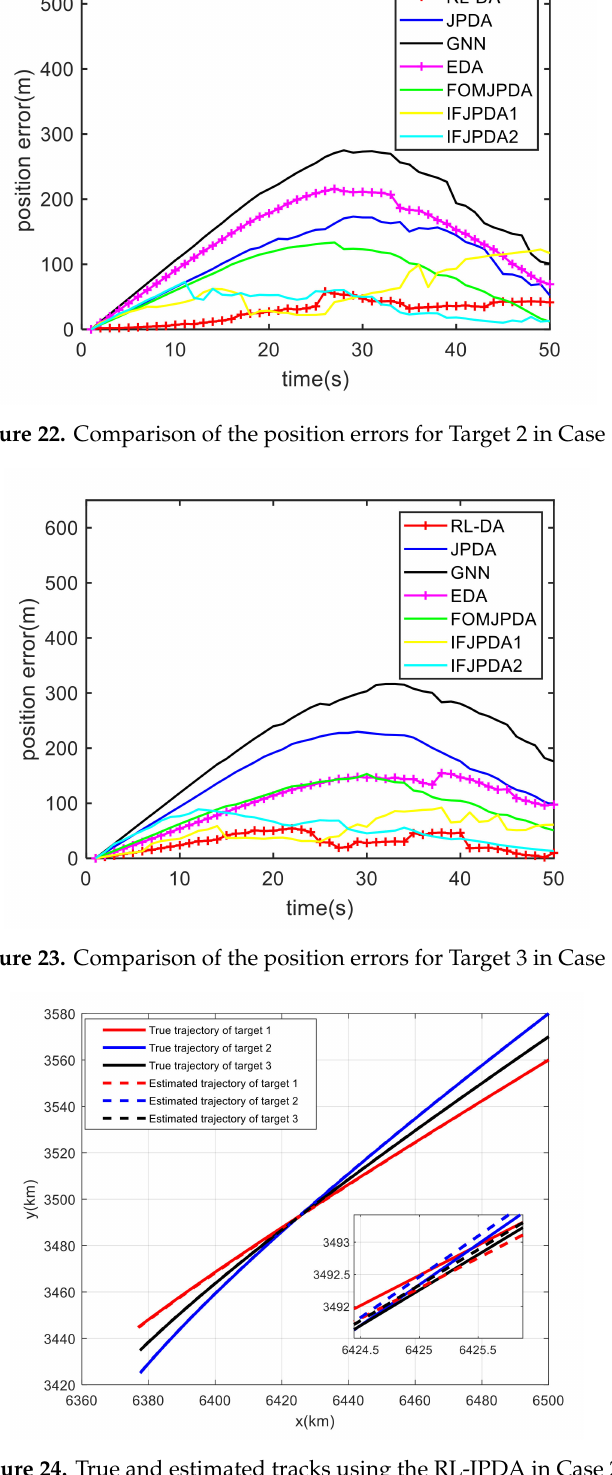
Figure 24. True and estimated tracks using the RL-JPDA in Case